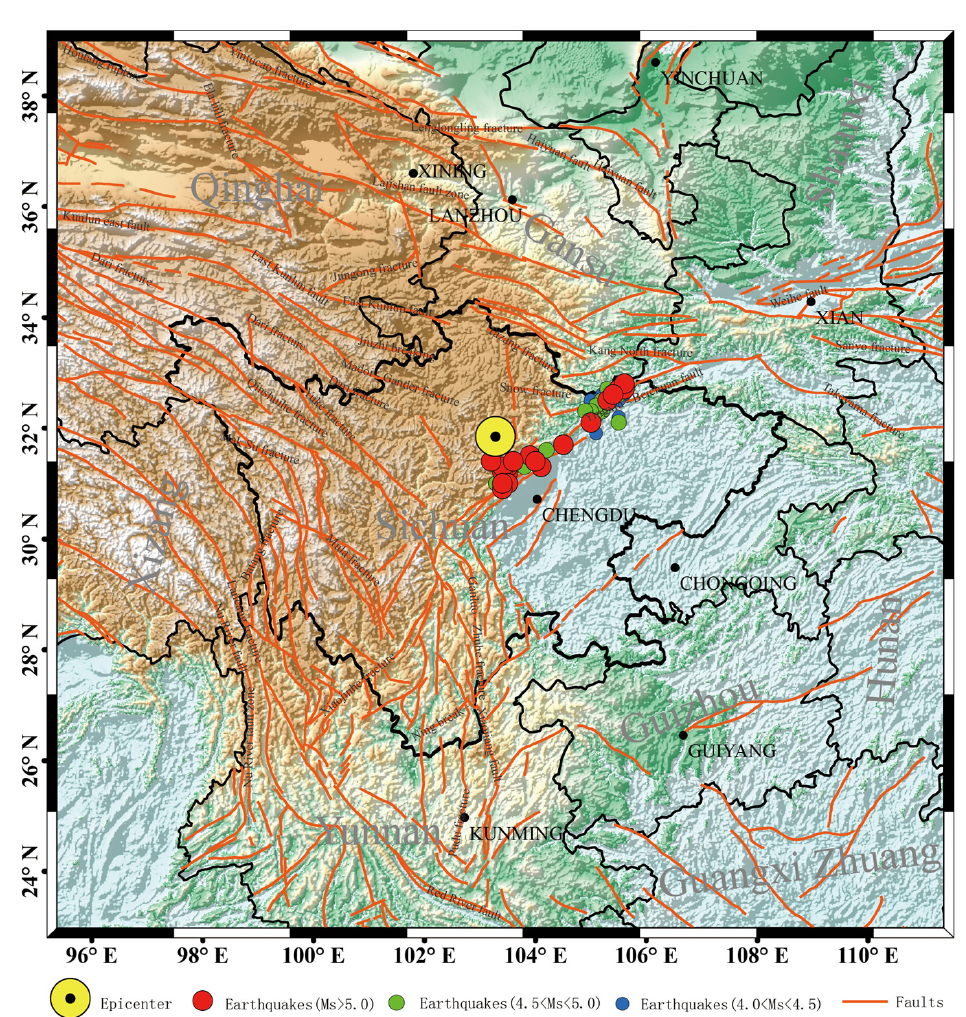
Figure 1. The investigated area of the Wenchuan earthquake. The epicenter of the Wenchuan earthquake occurred on May 12, 2008, is marked with a yellow cride, the main faults is marked with pink